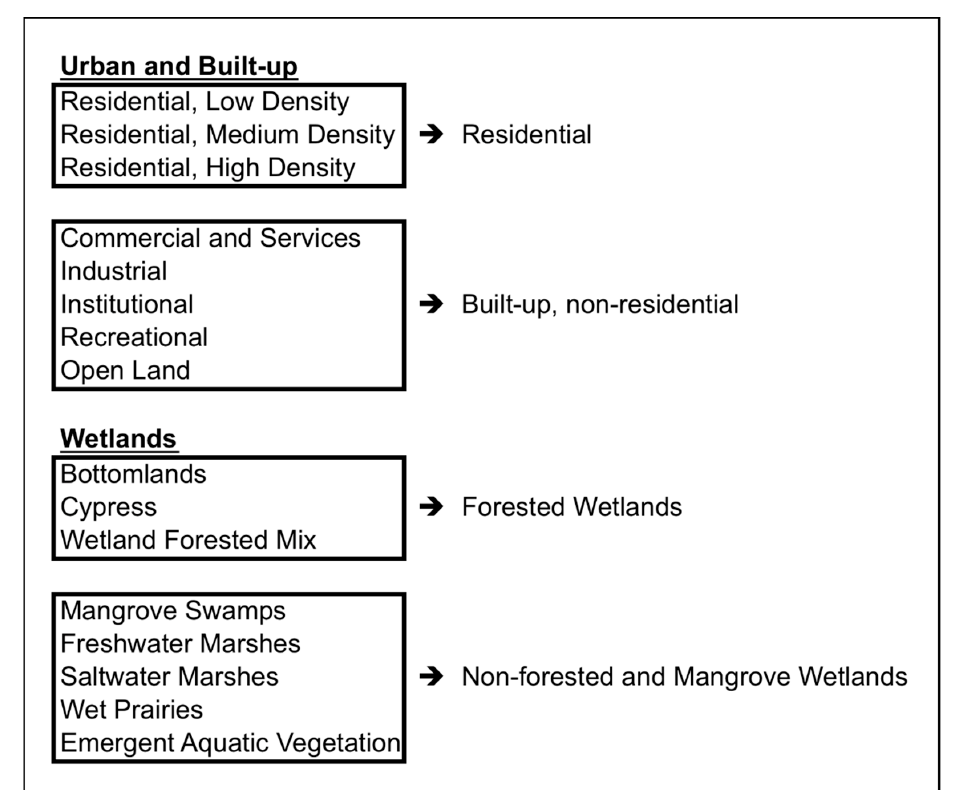
Figure 5. Group decisions based on AGTC kg plot − 1 pairwise comparisons for Level II sub-classes of the Level I “Urban and Built-up” and “Wetlands” SWFWMD classes.